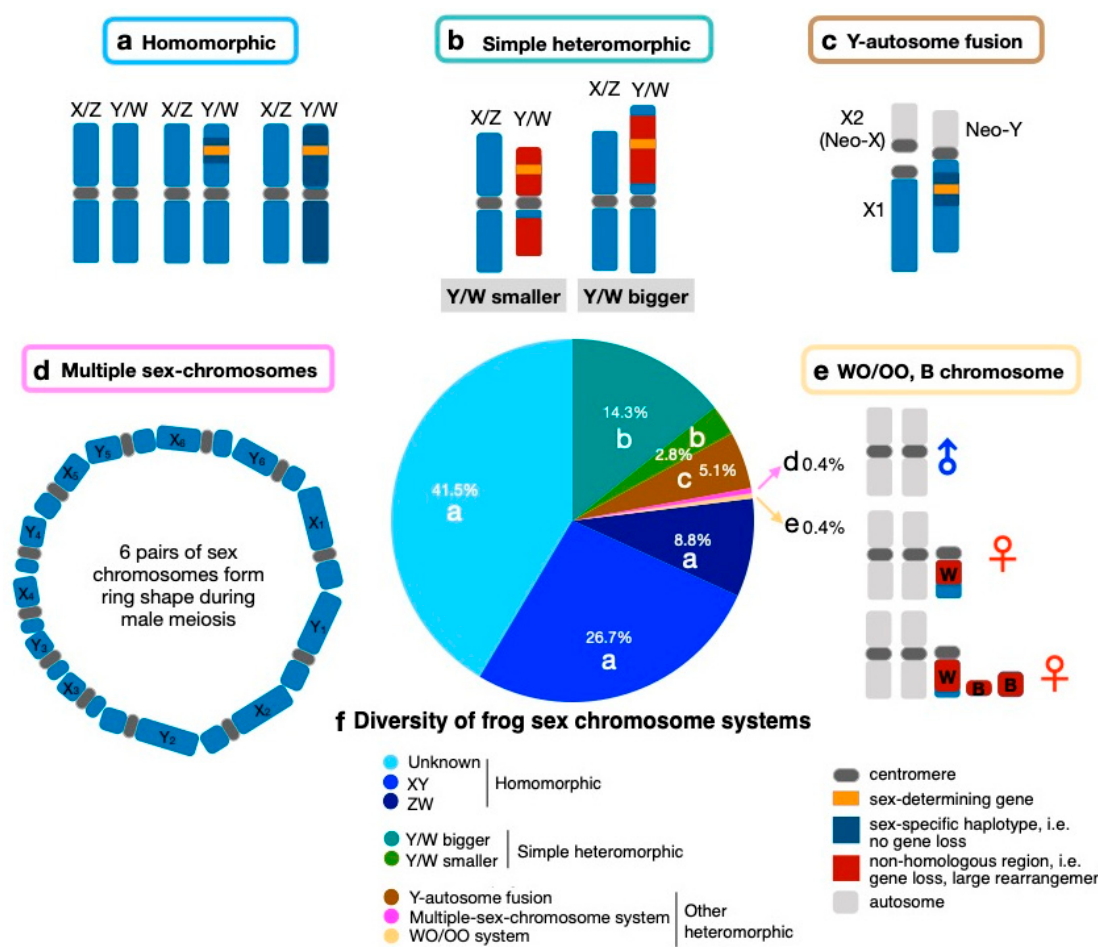
Figure 1. Diversity of frog sex chromosome systems. ( a ) Homomorphic sex chromosomes—sex-specific haplotype can vary largely from very small to the full length of the homologous X/Z, within or across populations within species. ( b ) Simple heteromorphic sex chromosomes—the Y/W may be bigger or smaller than X/Z. ( c ) Y-autosome fusion generating Neo-X (X 2 ) and Neo-Y. ( d ) Multiple sex chromosomes in Leptodactylus pentadactylus , where 6 pairs of sex chromosomes form a ring shape during meiosis. ( e ) WO/OO and supernumerary (B) chromosomes in Leiopelma hochstetteri , with population-specific W and various forms of B chromosomes, which are never observed in males. ( f ) Pie chart shows the proportion of sex chromosome systems in Anuran frogs. All the non-homomorphic sex chromosome types, such as b, c, d and e systems, are heteromorphic.